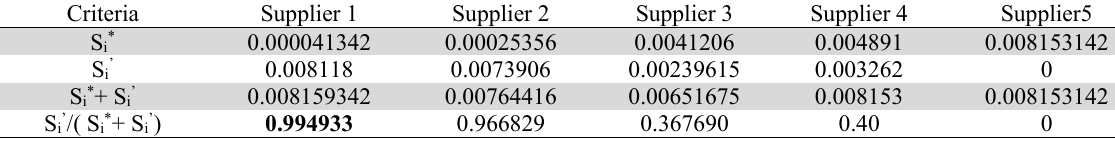
The comparative closeness of different suppliers